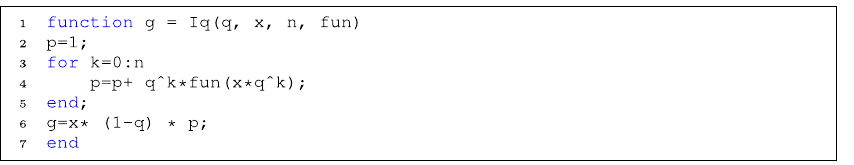
Algorithm 4 The proposed method for calculated